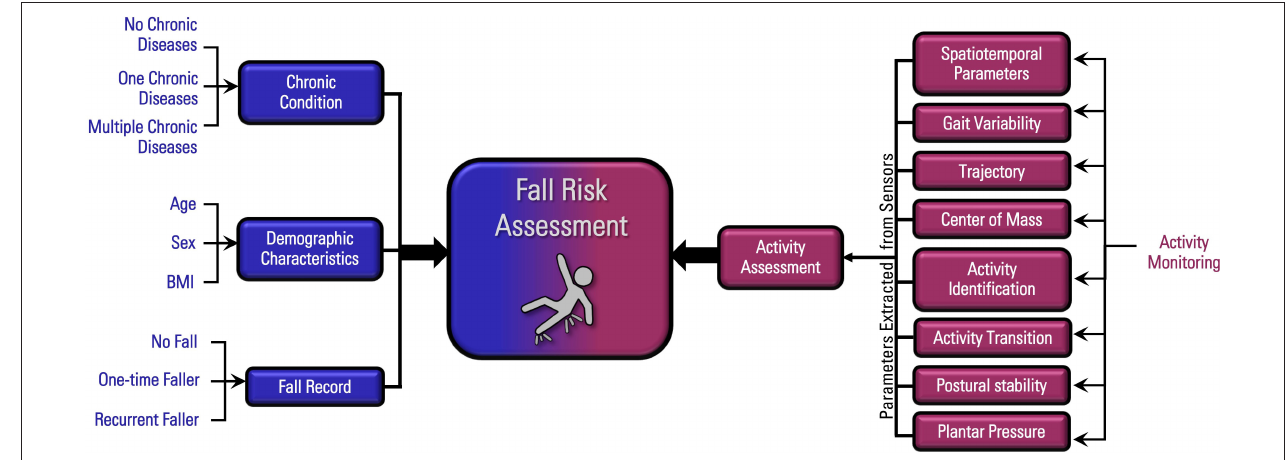
FIGURE 5 | Overall flow diagram of fall risk